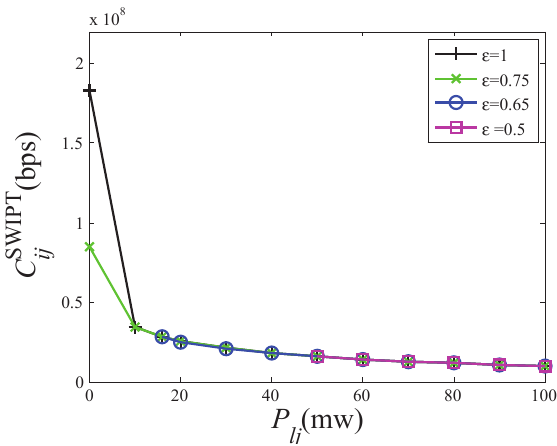
Figure 9. The impact of energy converting coefficient on SWIPT capacity.